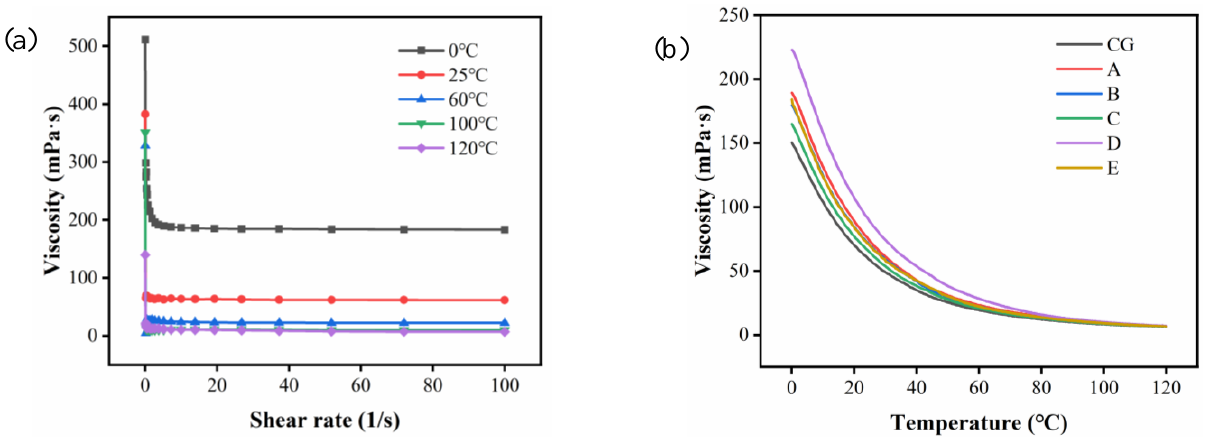
Figure 4. ( a ) Viscosity versus shear rate curve of different temperatures; ( b ) effect of temperature on the viscosity of different camellia oil samples: (CG) CVO; (A) 200 nm; (B) 140 nm; (C) 20 nm; (D)15 nm; (E) 10 nm.